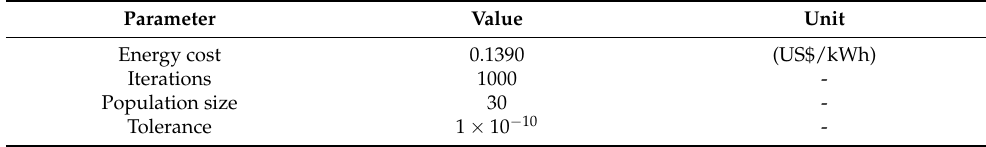
Table 3. General simulation